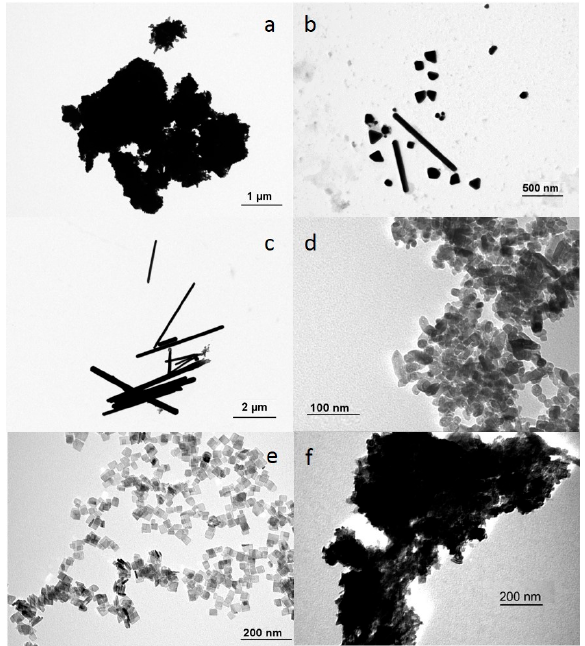
Figure 1. TEM images of ( a ) Ag nanospheres; ( b ) Ag nanoplates; ( c ) Ag elongated nanorods; ( d ) TiO 2 nanobipyramids; ( e ) TiO 2 nanoplates; and ( f ) TiO 2 nanospheres.